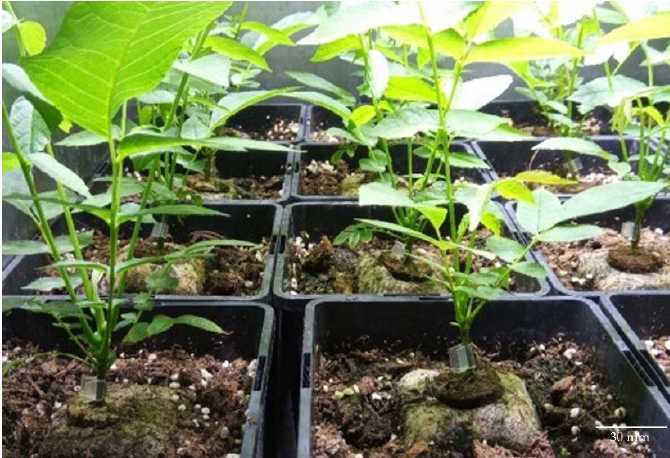
Figure 8. Grafted plants fully acclimatized, ready to be transferred into a greenhouse.